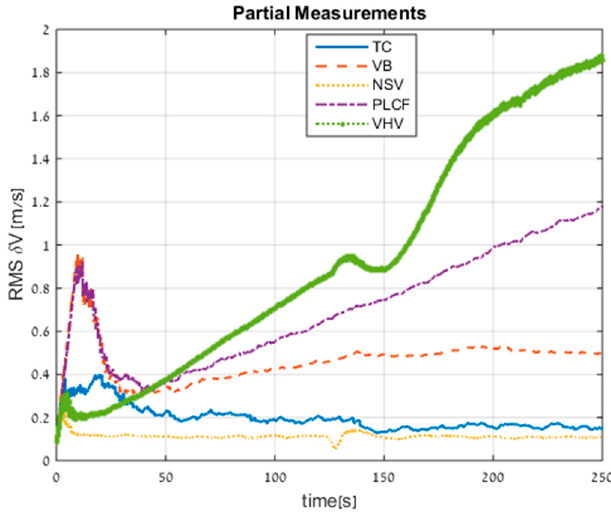
Figure 11. RMS errors of velocity for all approaches obtained from trajectory #2.